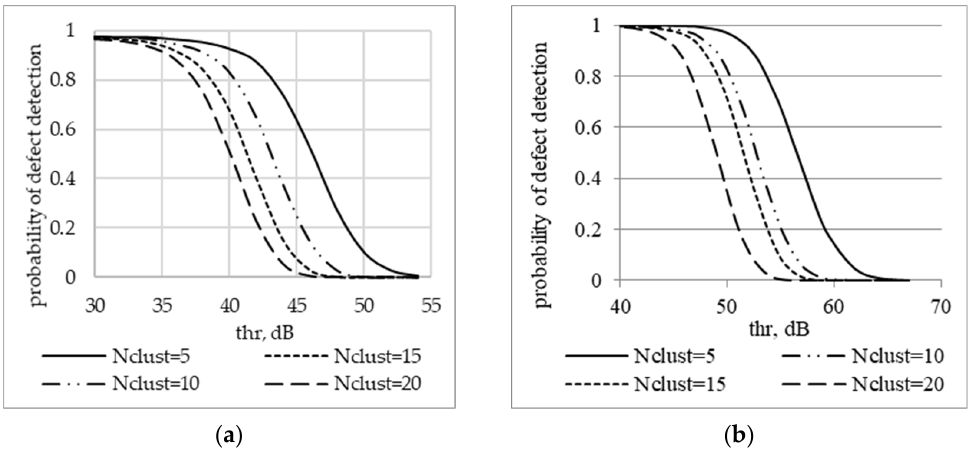
Figure 13. Probability of fatigue crack detection depending on the threshold value for different N clust for steels 09G2S ( a ) and 45 ( b ).